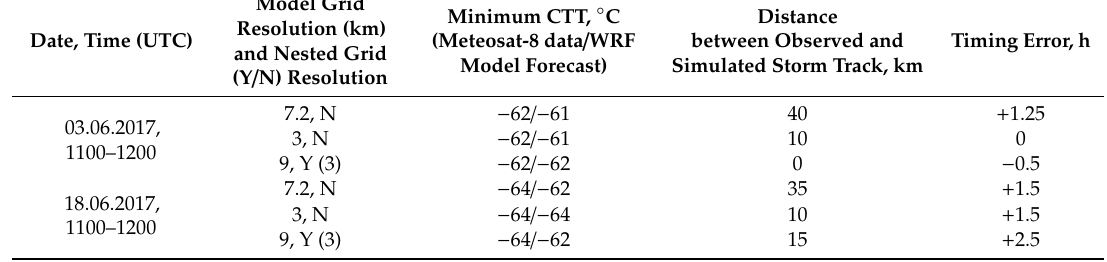
Table 4. Comparison of simulated storms characteristics with Meteosat-8 satellite data.